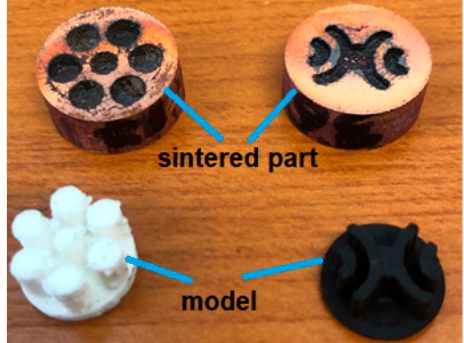
Figure 1. Different internal sample architectures.